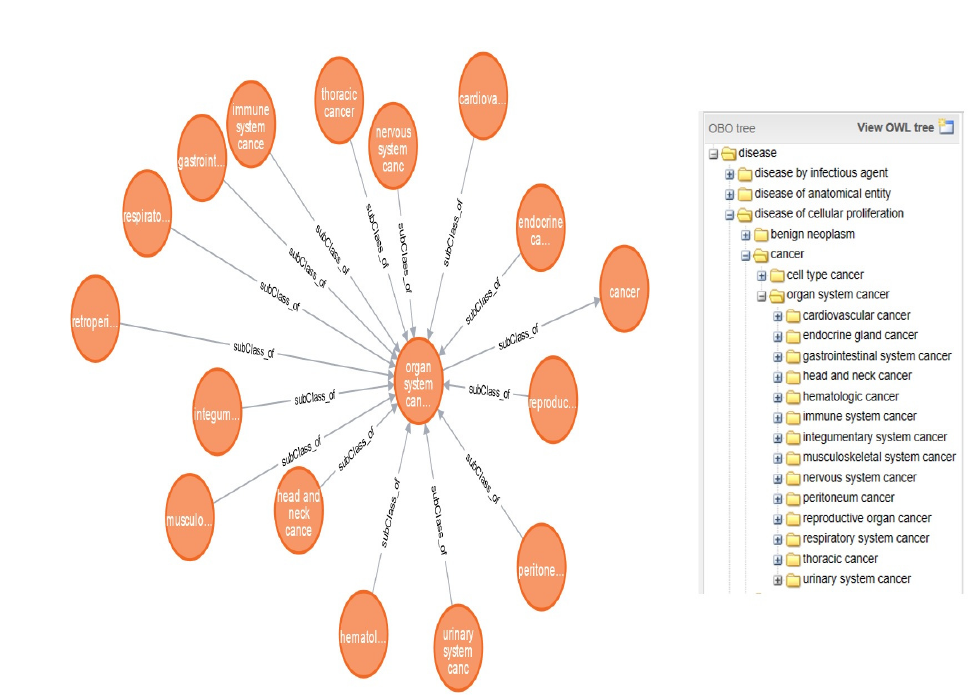
Figure 5. A subgraph of ‘organ system cancer’ concept with its superclass, subclasses, and the corresponding DO sub tree.